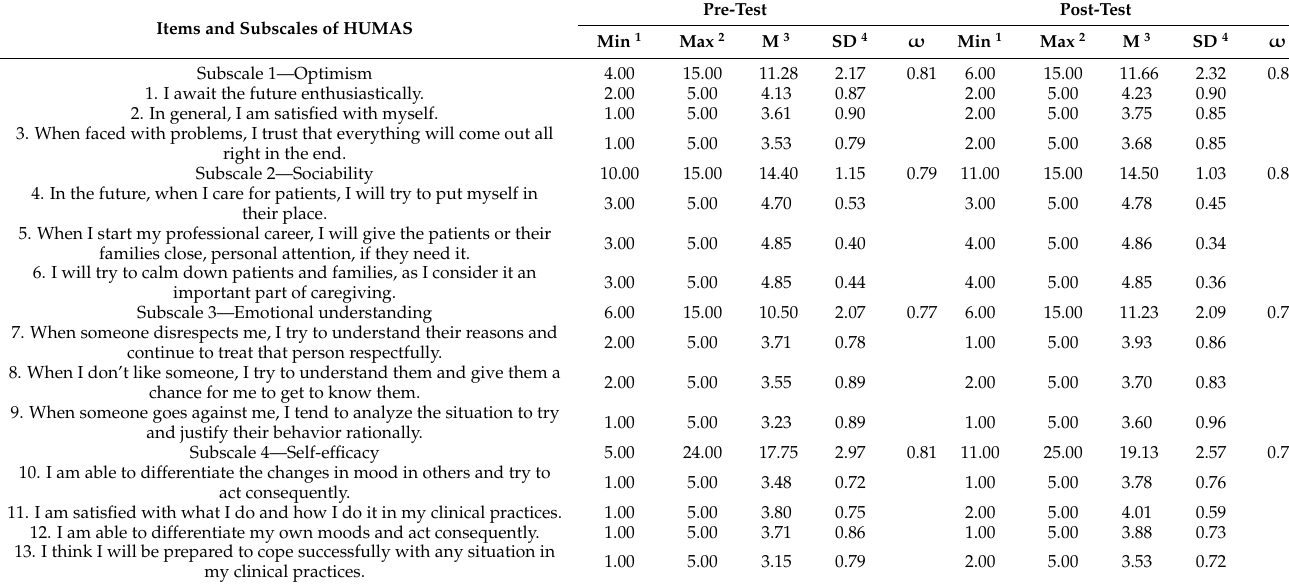
Table 1. Descriptive data (minimal, maximal and mean scores, and standard deviation) and reliabili- ties for each item, subscale and the total score obtained in HUMAS at baseline (pre-test) and after virtual simulation sessions (post-test) (N =